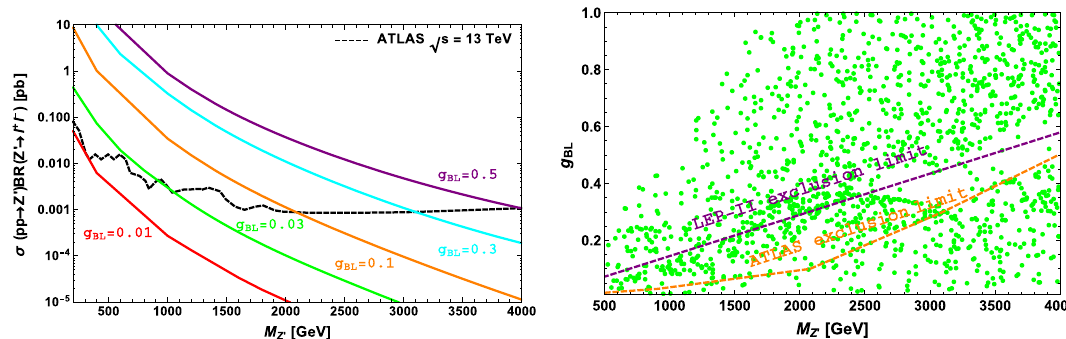
Fig. 13 Colored lines in left panel represent the dilepton signal cross section as a funciton of M Z (cid:2) for different values of g BL with the black dashed line points to ATLAS bound [105]. Right panel projects the constraint by ATLAS and LEP-II [106] on the gauge parameter space for M D with s-channel contribution is supposed to give resonance in , H (cid:2) the propagator ( Z (cid:2) , H (cid:2) 2 4